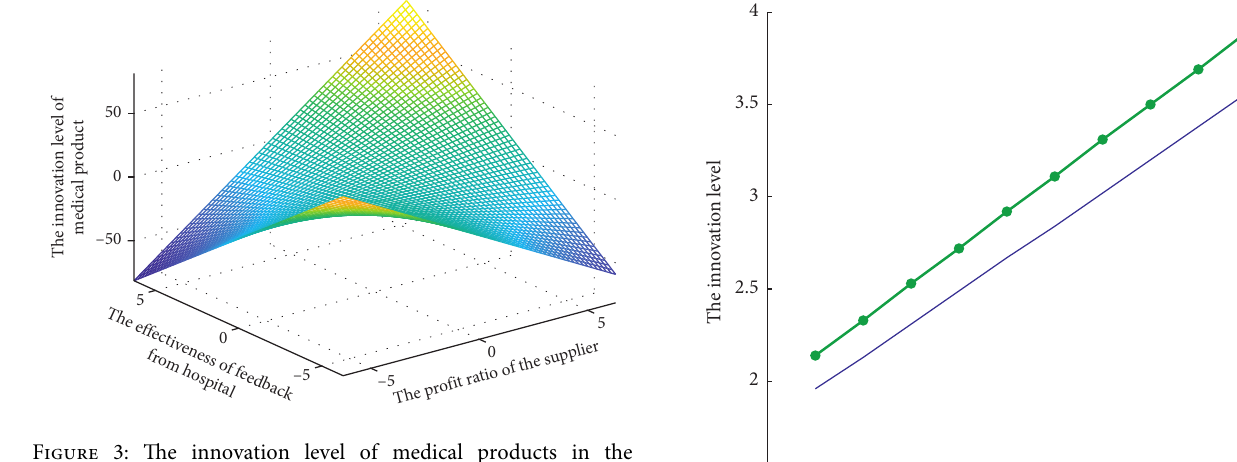
Figure 3: The innovation level of medical products in the decentralized strategy.